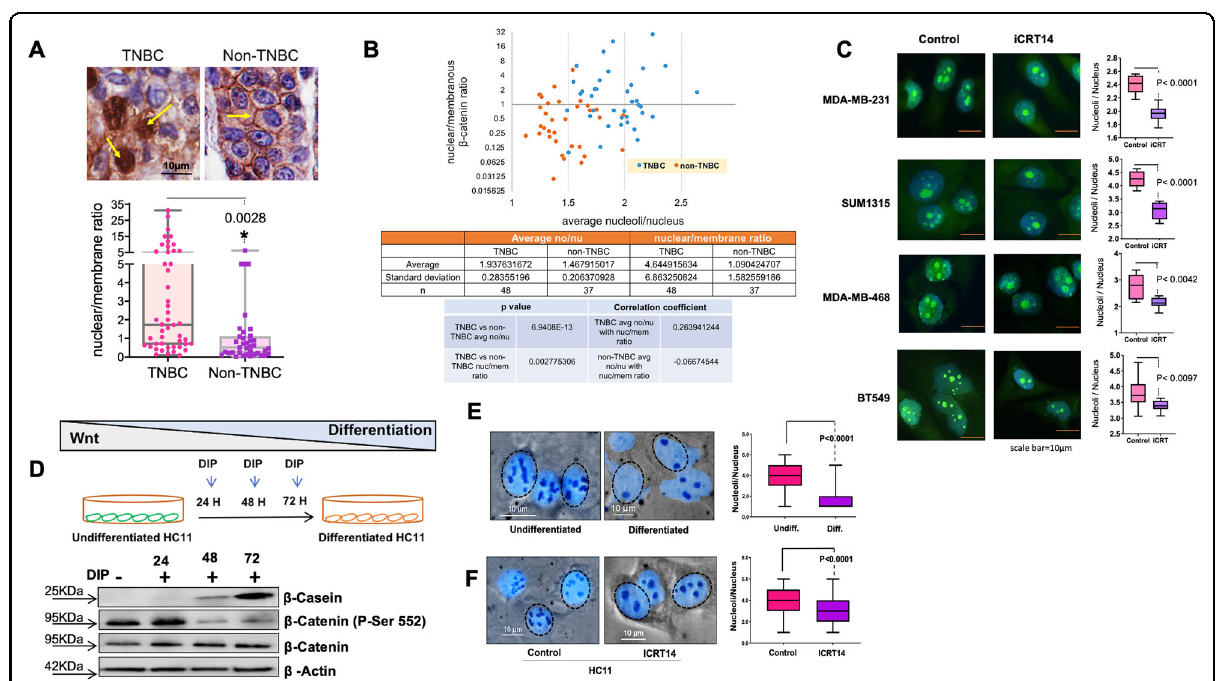
Fig. 3 Active β -catenin signaling in TNBC contributes to the increase in nucleolar number. A Patient-derived breast cancer specimen was stained for β -catenin illustrating a reduction in nuclear to the membranous ratio of β -catenin indicating a reduction in active β -catenin signaling in non-TNBC patient tumor samples compared to TNBC patient tumor samples. Representative pictures of immunohistochemical staining for β -catenin in TNBC and non-TNBC specimens. Yellow arrows indicate intense staining locations for β -catenin. The staining was scored for nuclear β -catenin staining as well as membranous β -catenin staining. The ratio of nuclear vs. membranous β -catenin is depicted in the box and whiskers plot. Each dot indicates the ratios corresponding to each patient specimen. Statistical analysis was performed with a T -test and error bars indicate SEM. B A comparison of the ratio of nuclear vs. membranous β -catenin staining against the nucleolar number of each patient-derived specimen indicates the correlation between active Wnt signaling, nucleolar number, and breast cancer subtype. The tables below the plot summarize the details of specimens and statics. C TNBC cell lines were treated with β -catenin inhibitor iCRT14 at 5 µM for 48 h result in a signi fi cant reduction in the number of nucleoli per nucleus in TNBC cell lines. Representative photomicrographs of NucleolarID TM stained cells are presented. The accompanying box plots present the average nucleoli/nucleus number for each cell line for the control and iCRT treated groups. Statistical analysis was performed using a T -test and error bars indicate SEM. D Graphical representation of Wnt signaling activity in HC11 cells throughout the process of differentiation. DIP = dexamethasone, insulin, prolactin cocktail for inducing differentiation. Total protein was isolated at 24, 48, and 72 h. Immunoblots for β -casein were used to verify the differentiation of HC11 cells. Immunoblots for active β -catenin (Phospho-Ser 552 is) and total β -catenin were performed to determine active β -catenin signaling. E Undifferentiated HC11 cells display higher numbers of nucleoli compared to differentiated HC11 cells based on AgNOR staining. Statistical signi fi cance was determined using a T -test and error bars represent SEM. F Treatment of HC11 cells with iCRT14 at 5 µM for 48 h resulted in a signi fi cant reduction in nucleolar number based on AgNOR staining. Statistical signi fi cance was determined using a T -test and error bars represent